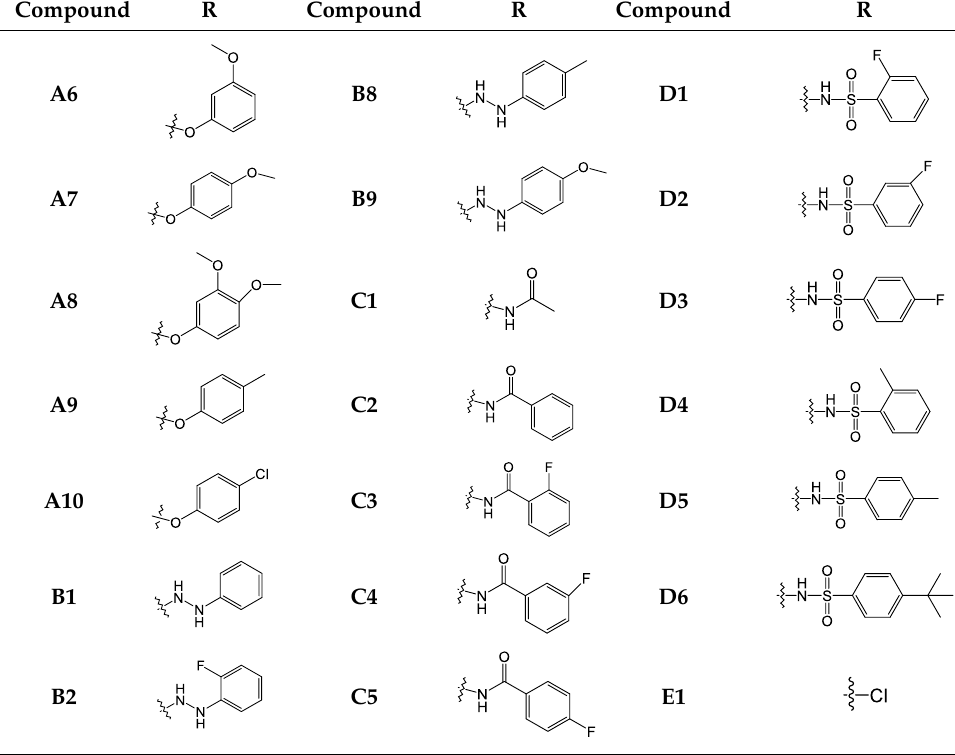
Table 1. Cont. Compound